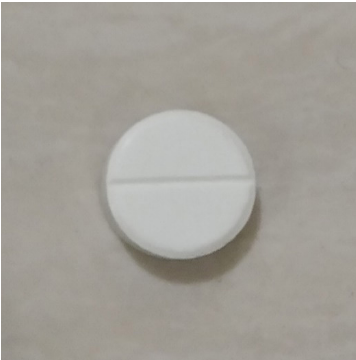
FIGURE 9 - Mucoadhesive buccal tablet of mefenamic acid.